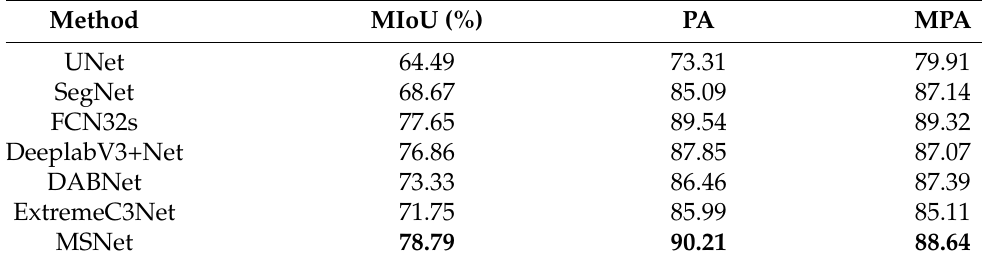
Figure 17. Comparison of the actual segmentation results. ( a ) Image; ( b ) label; ( c ) UNet; ( d ) SegNet; ( e ) FCN32s; ( f ) DeeplabV3Plus; ( g ) ExtremeC3; ( h ) DABNet; ( i ) MSNet. The part marked with a solid line represents a missing detection or a mistaken detection of the background as a real object, and the part marked with a dotted line indicates that different categories of real objects were confused. Table 6. Results of the four-class public